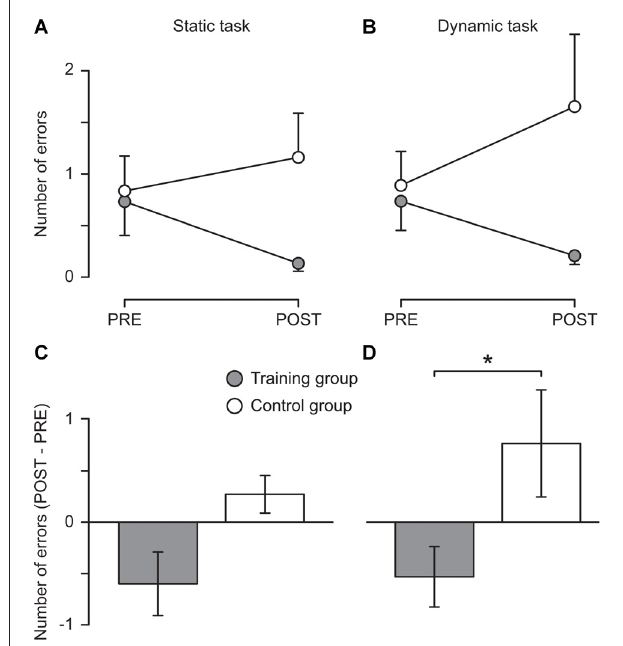
FIGURE 2 | Behavioral results. Mean number of errors committed during 15 s of one-legged stance on stable ground ( A ; Static task) and on a free-swinging platform ( B ; Dynamic task) before (PRE) and after (POST) 5 weeks of balance training (Training group, filled circles) or habitual activity (Control group, open circles). In (C,D) , the change from pre to post is displayed for the static and the dynamic task, respectively. An error was defined as touching the ground with the foot of the non-supporting leg or holding on to a handrail. For each participant, the mean of three trials was used. ∗ The change from pre to post differed significantly between groups ( p = 0.044). Error bars represent the standard error of the